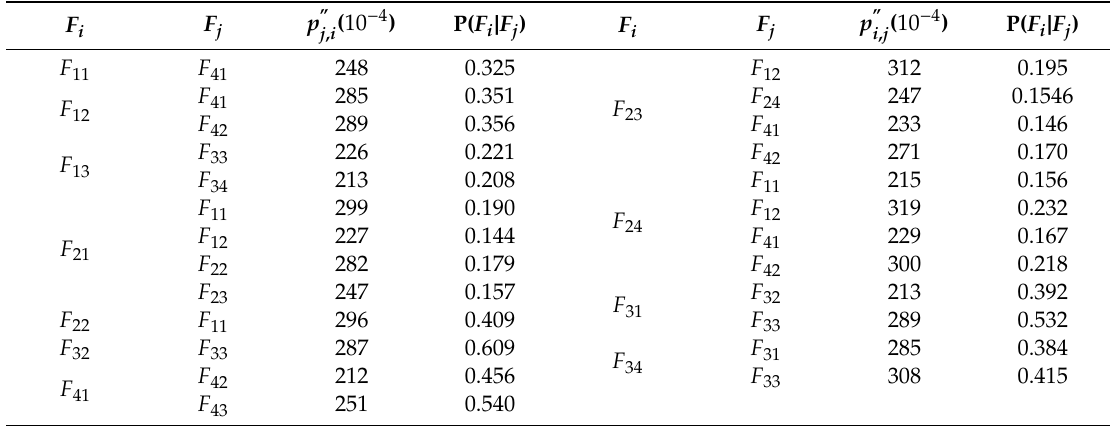
Table 7. The results of the conditional probability.